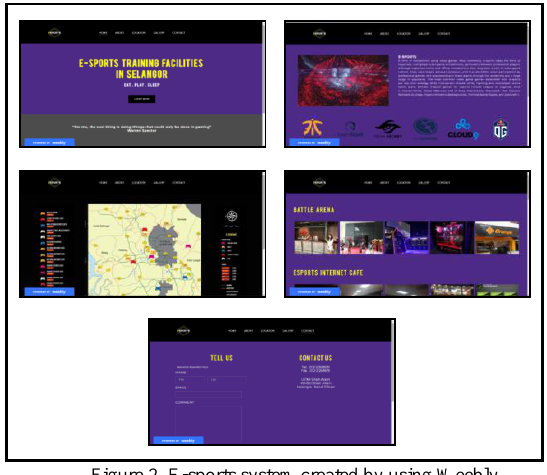
Figure 2. E-sports system created by using